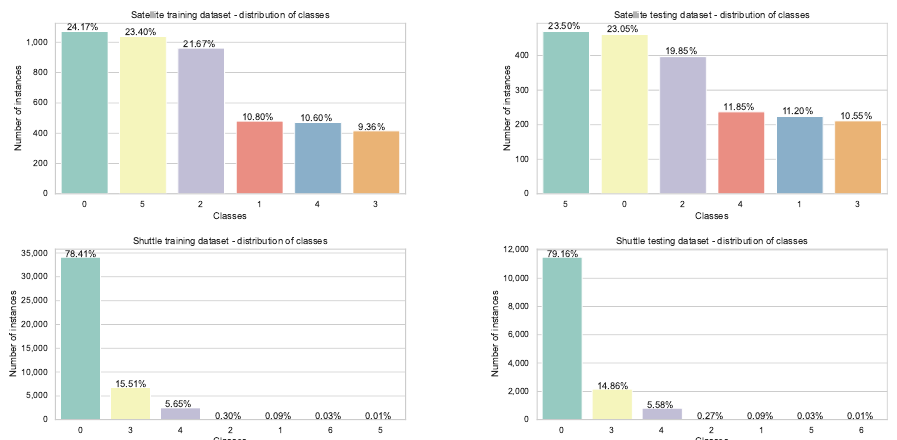
Figure 3. Distribution of classes in Satellite and Shuttle datasets with predetermined training and testing